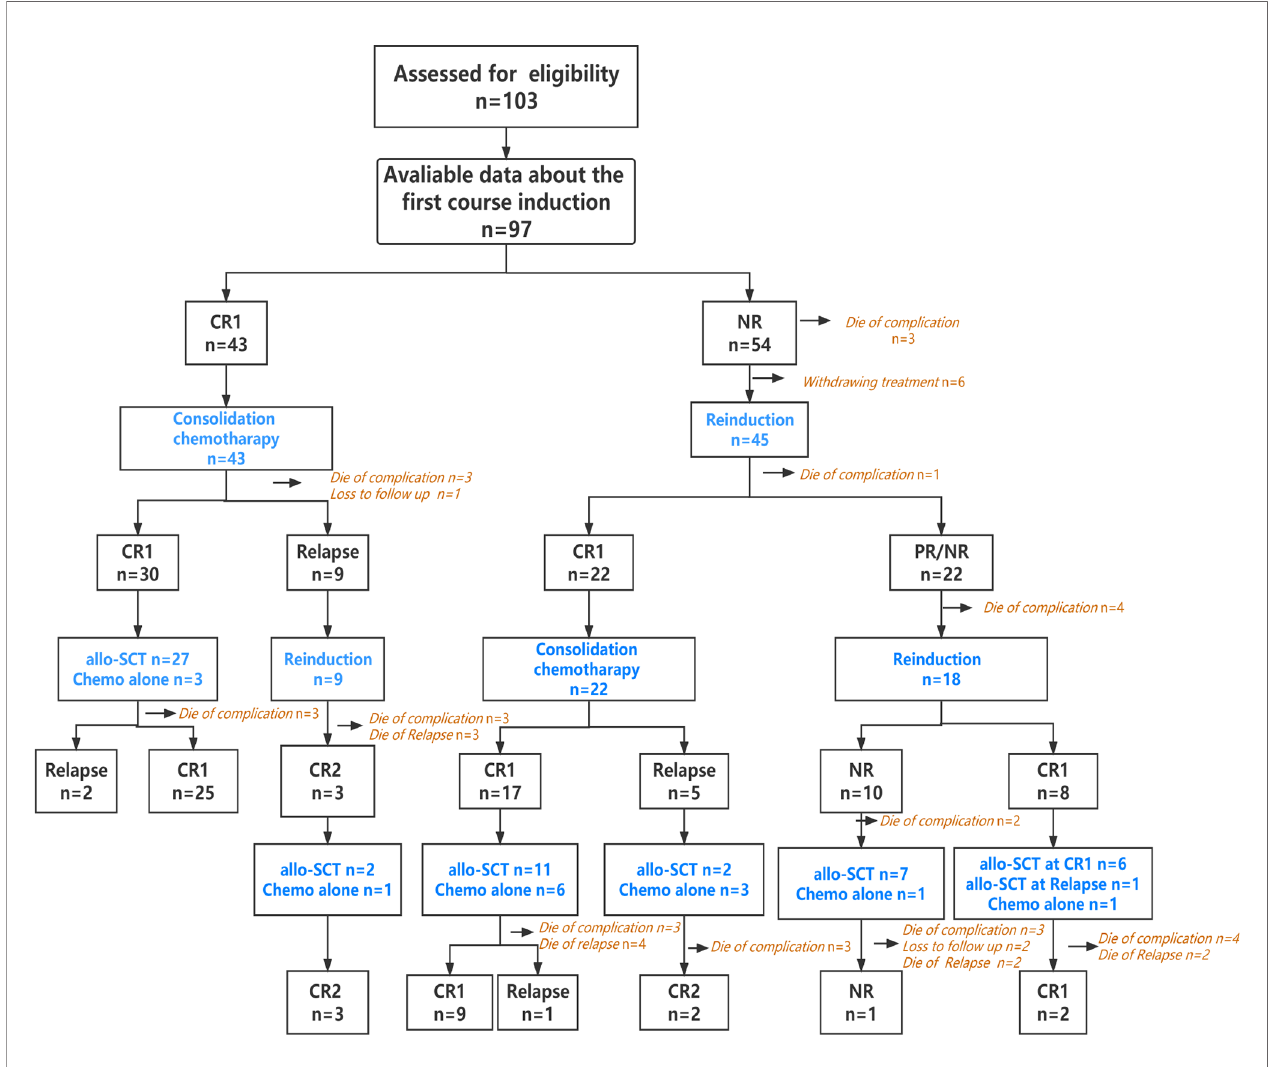
FIGURE 1 | Flow chart of ETP in this